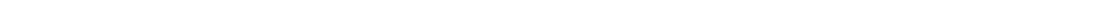
(See figure on previous page.) Fig. 5 Western blot analysis of MAPK signal transduction in hSF and SW982 cells. MAPK signalling was observed at 0, 5, 10, 15 and 30 min after the addition of TNF- α 10 ng/ml to hSF or SW982 cells pre-treated with 1 μ M sesamin as described in the Materials and Methods section. a Western blot results of MAPK signalling in hSF (left panel) and SW982 (right panel) cells under TNF- α -induced conditions with or without sesamin treatment. b Graphs of phosphorylation band densities of p38, p44/42 (ERK) and SAPK/JNK relative to the total form in hSF (left panel) and SW982 (right panel) cells. Values are presented as the mean±SEM (n=3). #, *= p <0.05; ##, **= p <0.01 versus control 0 min (#) or TNF- α treatment at various time points (*) by one-way